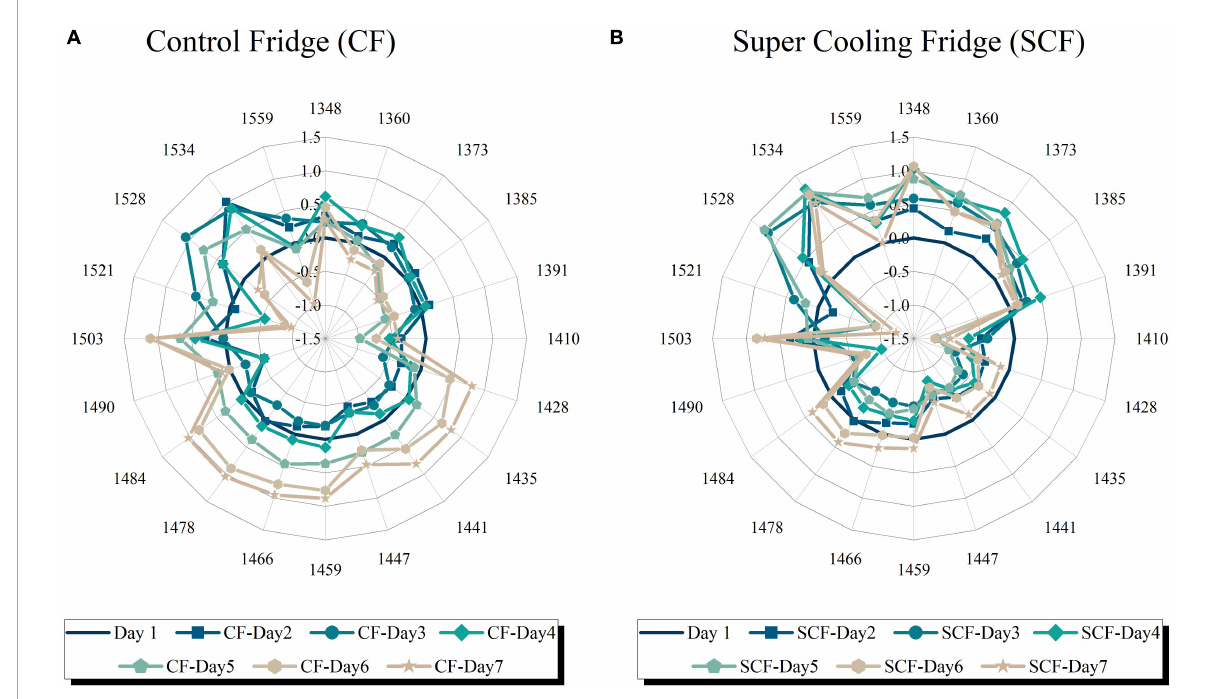
FIGURE7 Aquagrams of strawberries showing changes in water molecular matrix of the fruit flesh during 7 days of storage in: (A) Control fridge (CF) and (B) supercooling